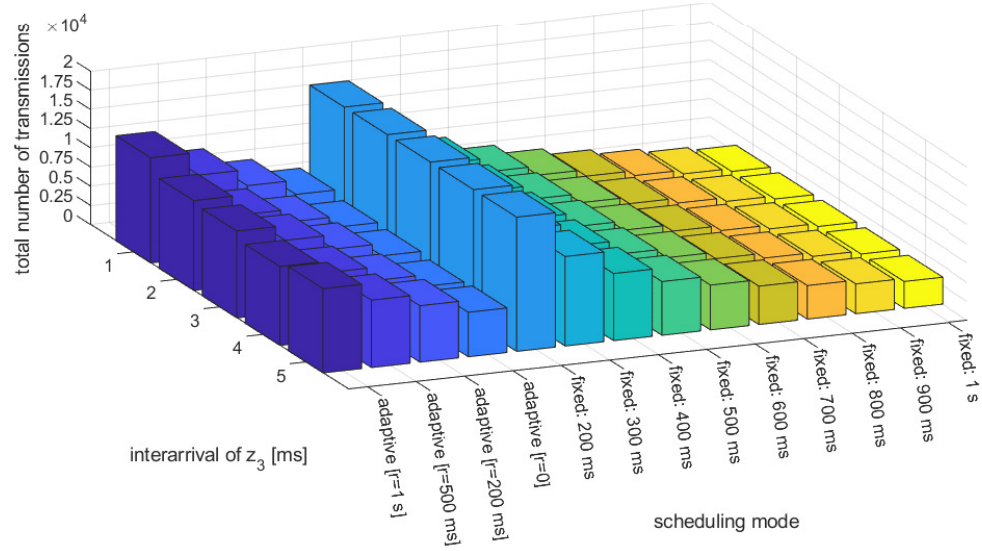
Figure 6. Total number of intra-platoon transmissions per simulation run (700 s) vs. selected transmission period and mean inter-arrival of z 0 random variable.